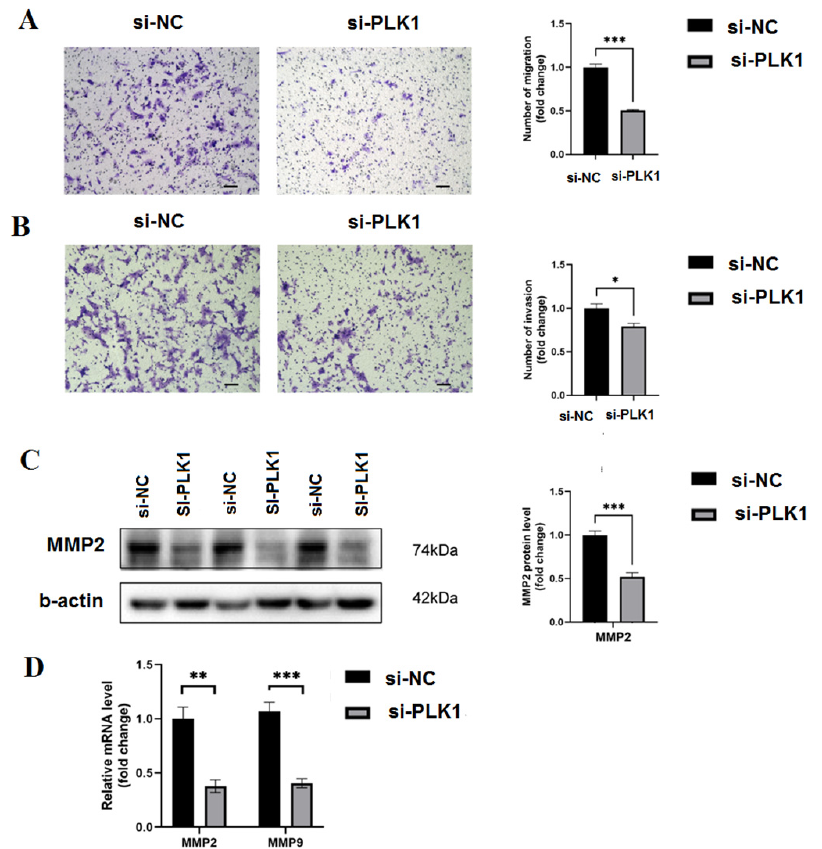
Figure 5. PLK1 stimulates trophoblast cells to invade and migrate: ( A ) the transwell assay was performed to measure the trophoblasts’ migration; ( B ) the transwell test was used to measure trophoblast invasion; ( C ) the impact of PLK1 on MMP-2 protein expression; and ( D ) qRT-PCR assesses how PLK1 knockdown affected the levels of MMP2 and MMP9 mRNA; * p < 0.05, ** p < 0.01, *** p <